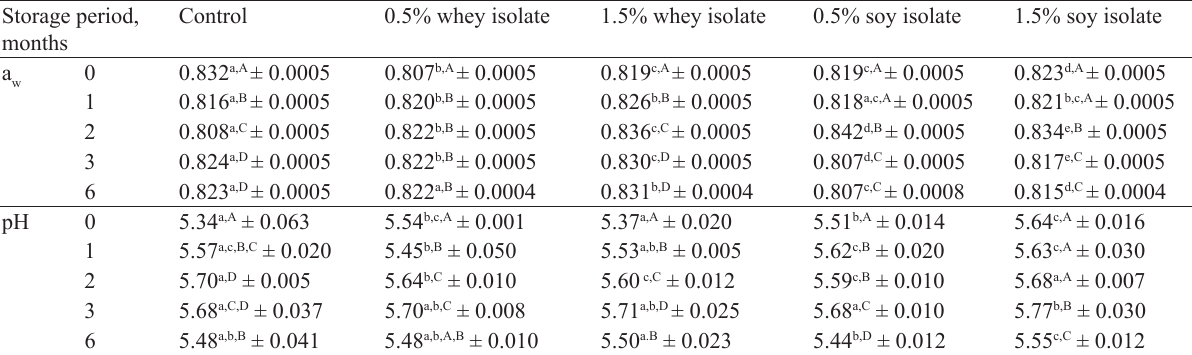
Table 2 Water activity and pH values of sausages with protein isolates (average value ± SD) Storage